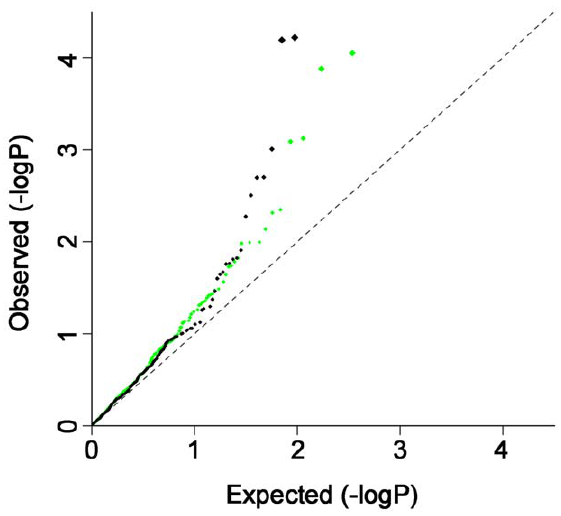
Figure 2. QQ plot of CD associated SNPs in RA and RA associated SNPs in CD. QQ plot of CD associated SNPs (p , 0.001) in RA (green) and RA associated SNPs (p , 0.001) in CD (black). The most strongly associated SNPs (after removing known risk loci) in one disease were further filtered for P , 0.001, and the resulting LD-pruned SNP sets were then tested for their distribution of association in the other disease. The QQ-plots indicate excess sharing of moderately associated SNPs across CD and RA.